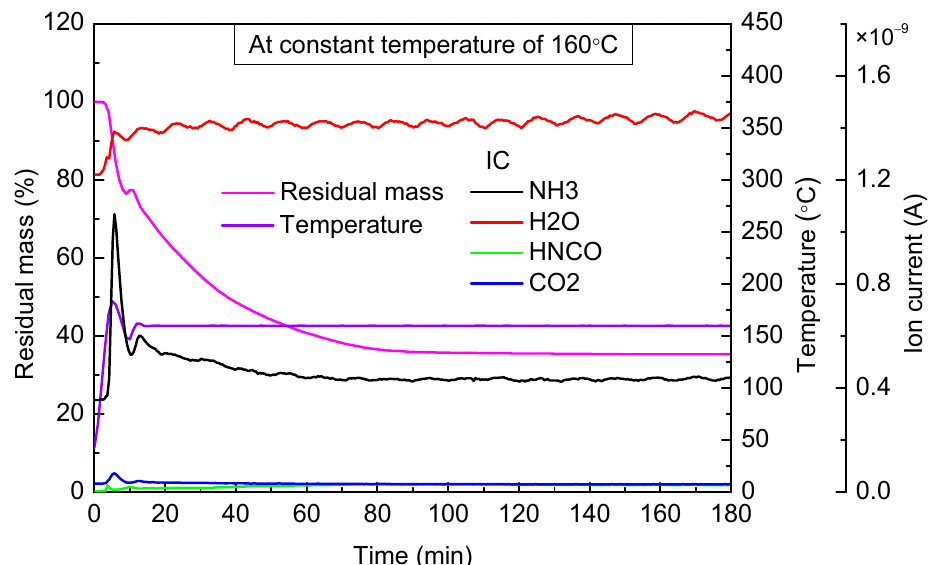
Figure 3. TG-MS results of urea at constant temperature of 160 °C.